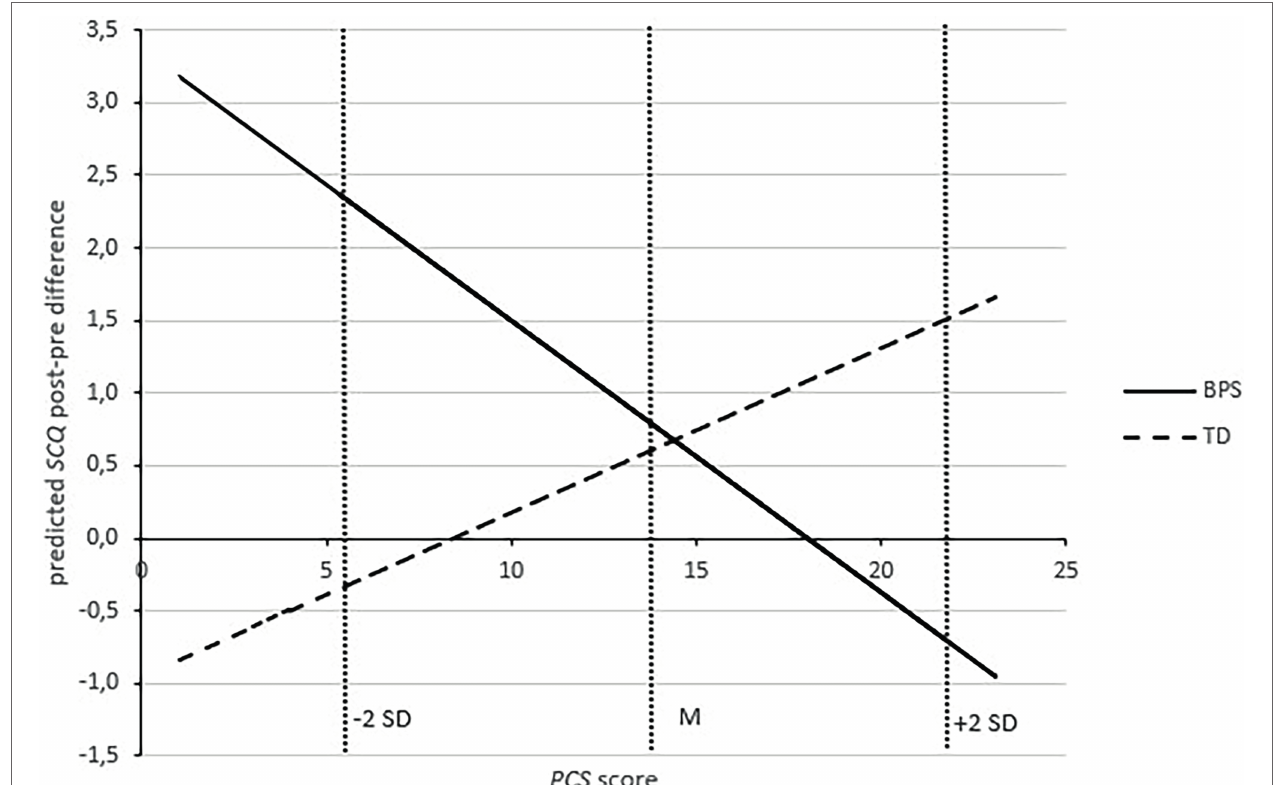
FIGURE 3 | Regression of change in situational pain catastrophizing (post minus pre difference) on dispositional pain catastrophizing (PCS score). Estimated SCQ values at means (M) and plus/minus two SDs of PCS score are indicated by vertical lines. Positive values indicate an increase in SCQ from the pre to the post measurement, while negative values indicate a decrease. BPS, Best Possible Self (experimental group). TD, Typical Day (control group). SCQ, Situational Catastrophizing Questionnaire. PCS, Pain Catastrophizing Scale.